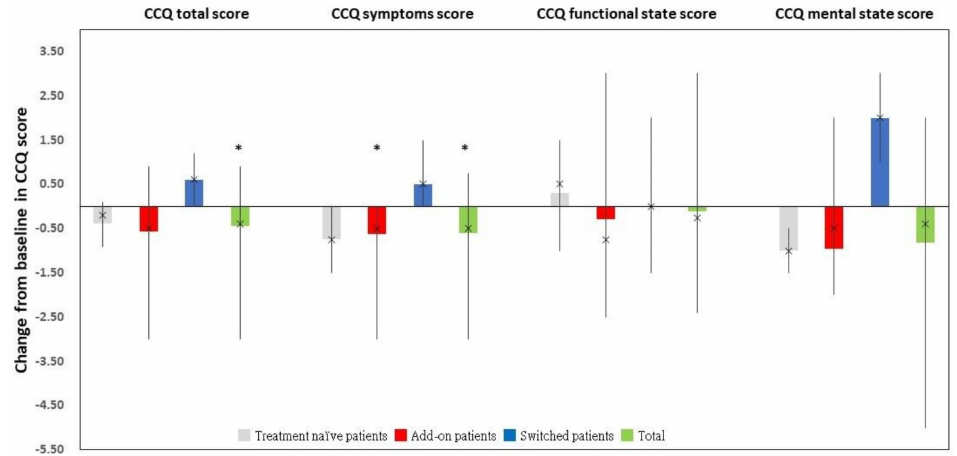
Figure 4. The change from baseline in CCQ total and domain scores in the “Changers” dataset and its corresponding subgroups. * p < 0.05. Abbreviations: CCQ, clinical COPD questionnaire.